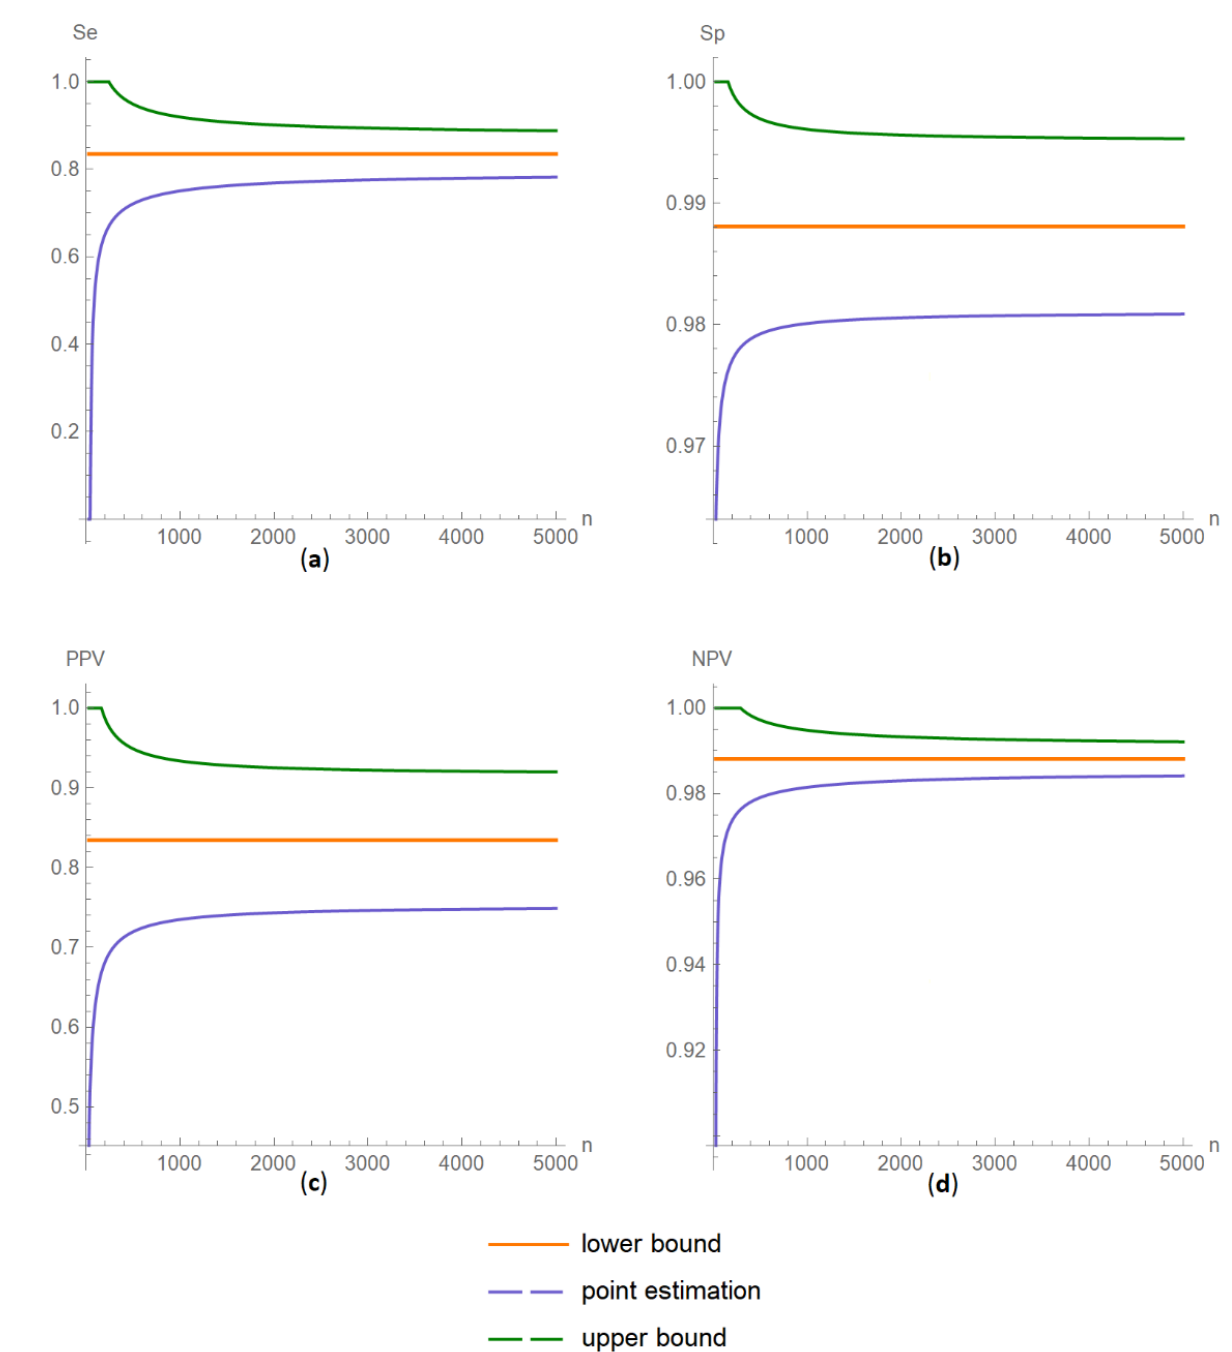
Figure 21. DAM confidence intervals versus population sample size plots. Plots of confidence intervals of ( a ) sensitivity Figure 21. DAM relative standard uncertainties versus population sample size plots. Plots of relative standard combined, ( Se ), ( b ) specificity ( Sp ), ( c ) positive predictive value ( PPV ) and ( d ) negative predictive value ( NPV ) versus total population measurement and sampling uncertainties of ( a ) sensitivity ( u ( Se )/ Se ), ( b ) specificity ( u ( Sp )/ Sp ), ( c ) positive predictive value sample size ( n ) curves, with the respective parameter settings in Table 4. ( u ( PPV )/ PPV ) and ( d ) negative predictive value ( u ( NPV )/ NPV ) versus total population sample size ( n ) curves, with the respective parameter settings in Table